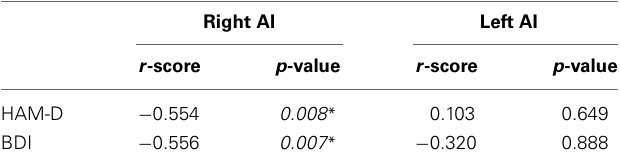
Table 5 | Partial correlations between intra-iFC in the right/left AI within the SN and severity of symptoms in patients with major